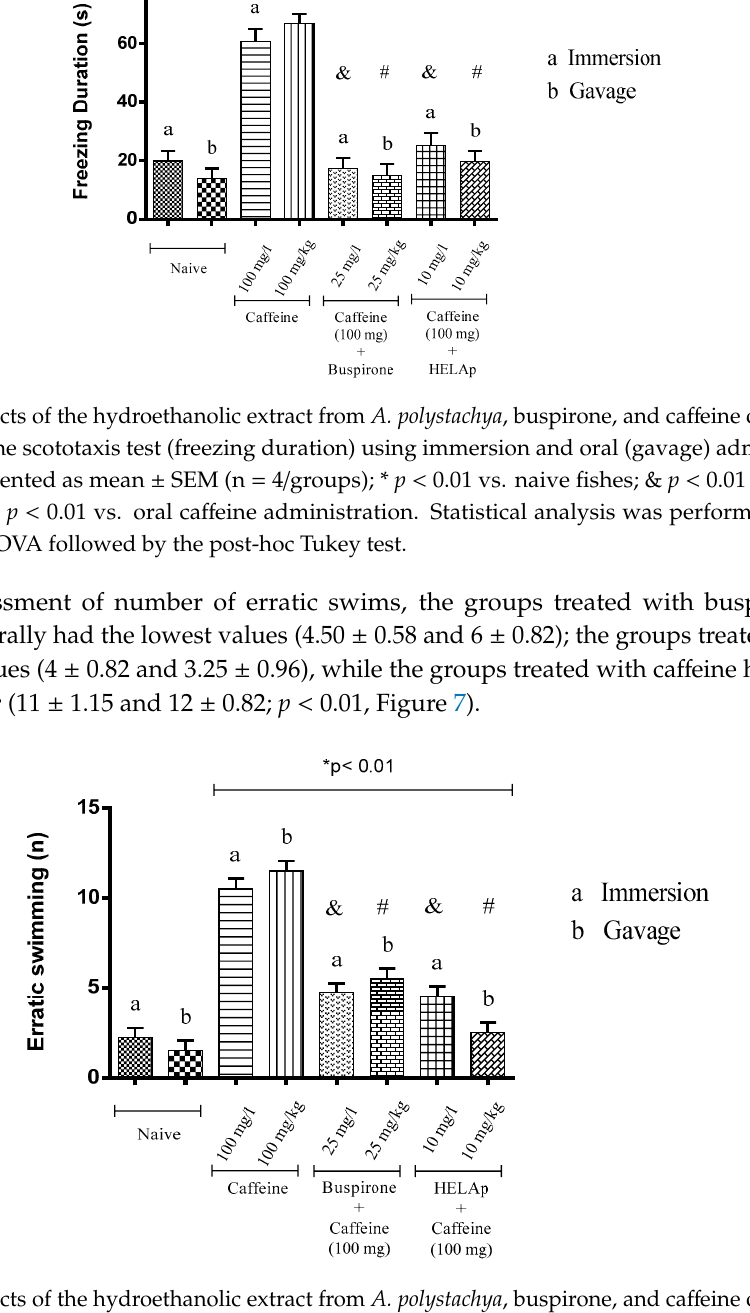
Figure 8. Effects of the hydroethanolic extract from A. polystachya , buspirone, and caffeine on zebrafish behavior in the scototaxis test (thigmotaxis), using immersion and oral (gavage) administration. Data are presented as mean ± SEM (n = 4/groups); * p < 0.01 vs. naive fishes; & p < 0.01 vs. caffeine immersion; # p < 0.01 vs. oral caffeine administration. Statistical analysis was performed through one-way ANOVA followed by the post-hoc Tukey test. In risk evaluation assessment, the groups treated with buspirone (6.75 ± 0.96 and 4.25 ± 0.96) and HELAp (8.50 ± 0.58 e 5.50 ± 0.58) had significantly lower values compared to the groups treated only with caffeine (18 ± 0.82 and 20 ± 0.82; p < 0.01, Figure 9). 050 100 150